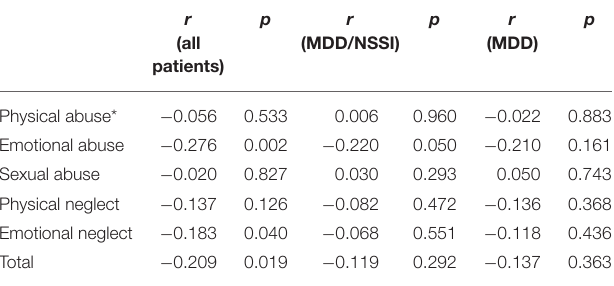
TABLE 5 | Correlations between cortisol and childhood trauma in all patients and MDD/NSSI patients.